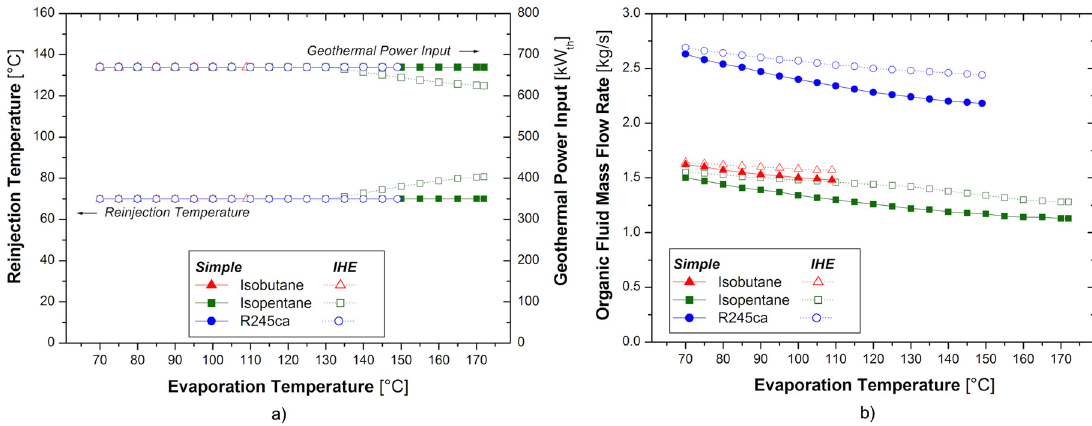
Figure 8. Influence of evaporation temperature on geothermal reinjection temperature and power input ( a ). Effect of the evaporation temperature on organic mass flow rate ( b ). Saturated